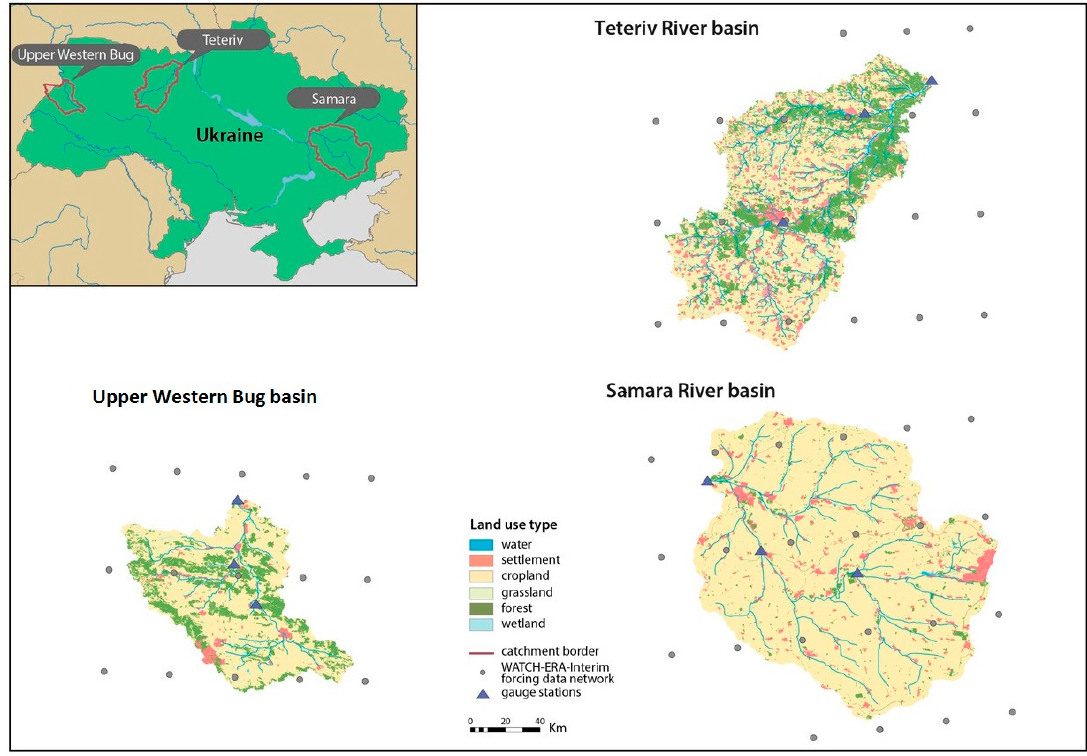
Figure 1. Three case study catchments in Ukraine with their land use patterns, gauge stations, and the WATCH-ERA-Interim forcing data network.